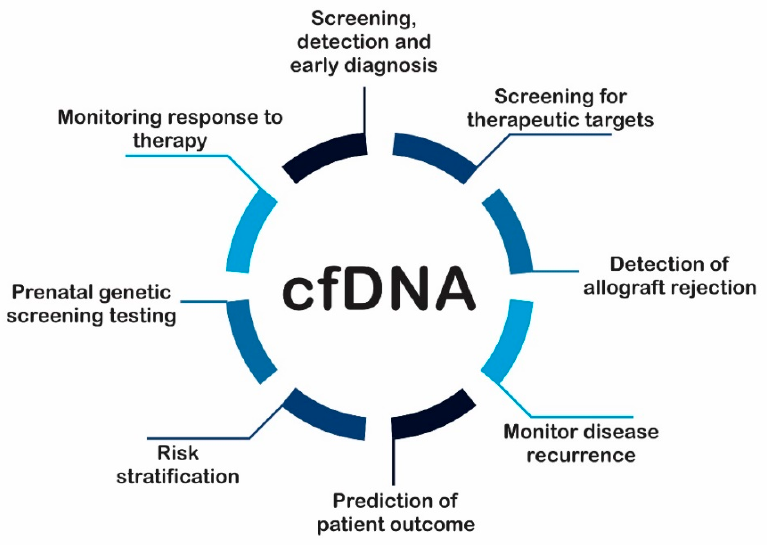
Figure 3. Potential clinical applications of cfDNA analysis. cfDNA can increase under abnormal conditions thus can be used as noninvasive biomarkers in several diseases and stages. cfDNA: circulating cell-free DNA.